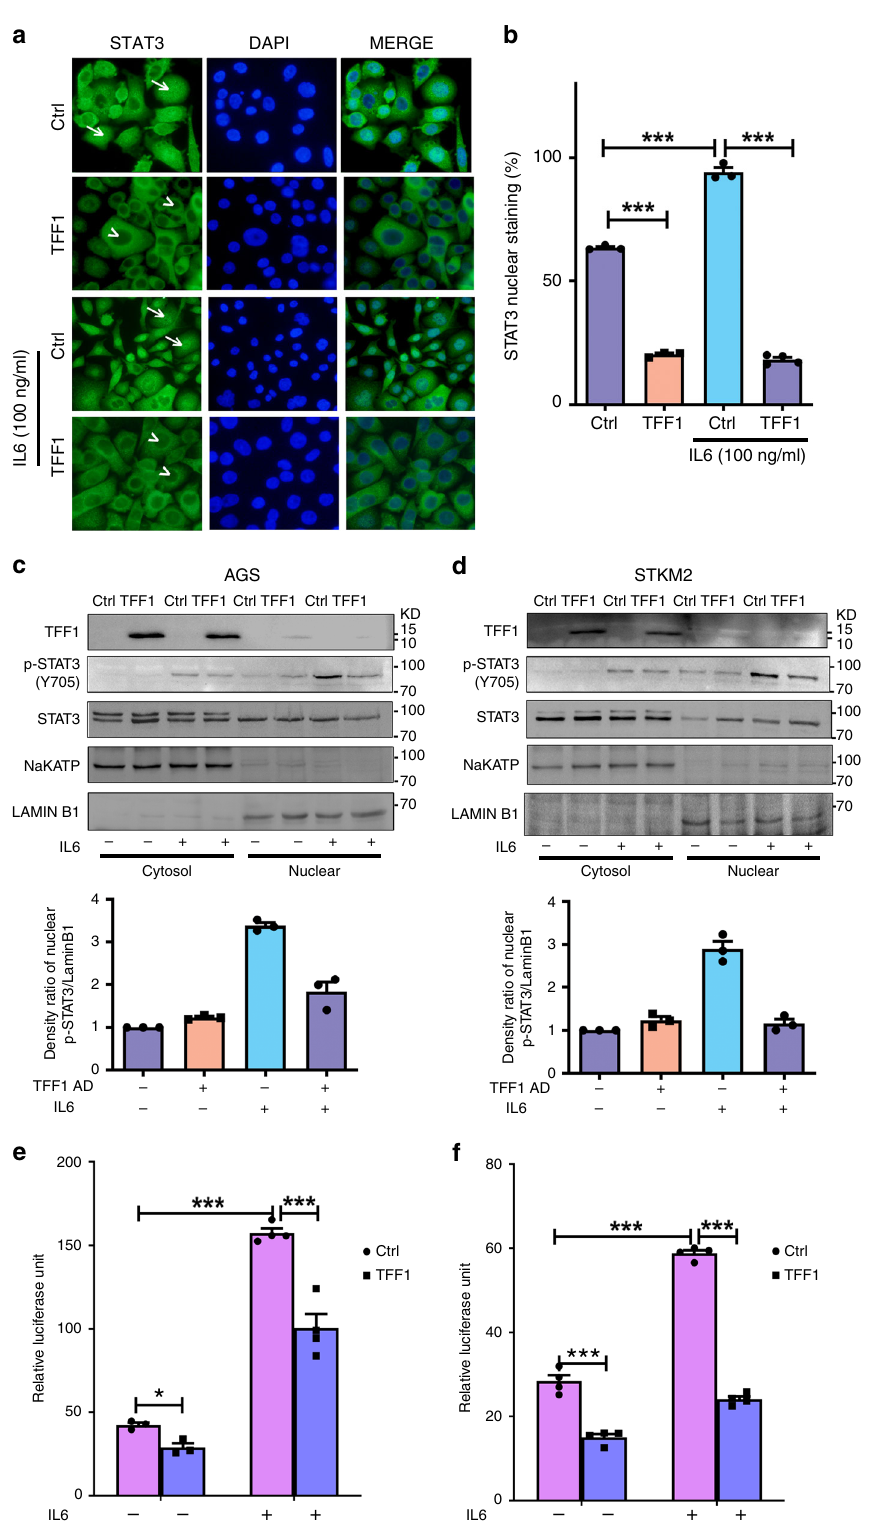
protein and AGS-TetOne cells expressing TFF1 (Supplementary Fig. 7c, d, P <